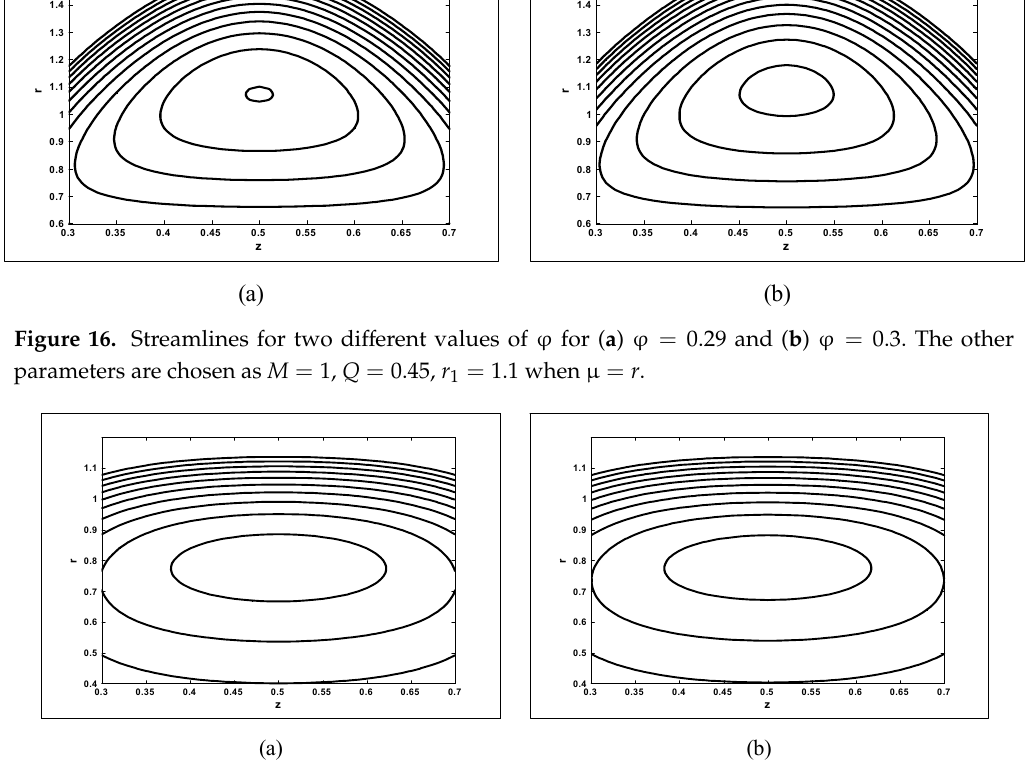
= M The other r = = ,4.0 = Q 1.1 = r when 1 μ . r 1